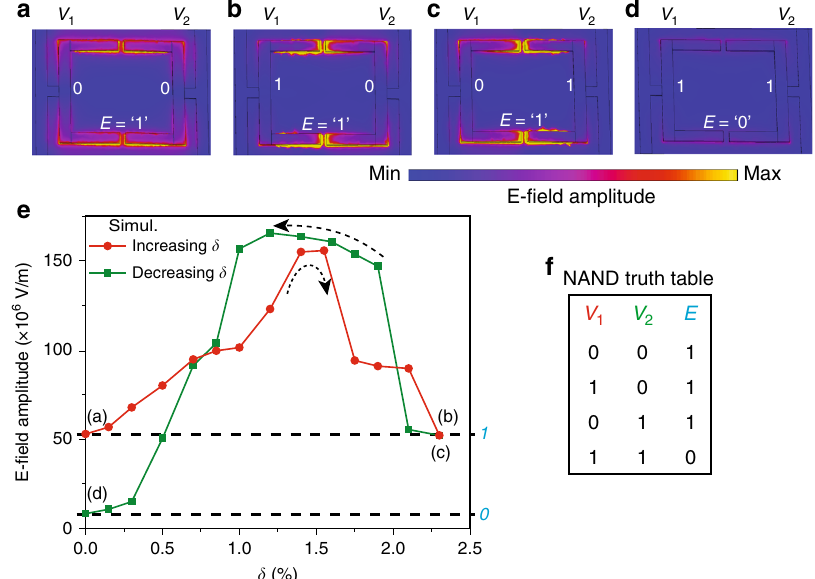
Fig. 5 NAND logic gate and multiple-input – output states in the near- fi eld con fi ned energy of MEMS Fano-metasurface. a – d The numerically calculated electric fi eld distributions at 0.55 THz, where a – c represent the true states of the electric fi eld con fi nement ( E = 1 ), whereas d shows the false state of E (i.e. E = 0 ), signifying the construction of NAND logic operation that is tabulated in ( f ). The input logic states 0 and 1 for V 1 and V 2 represent the ‘ up ’ and ‘ down ’ actuation states of SRR cantilevers, respectively. e Distinctive variations shown for the enhanced spatially con fi ned electric near- fi eld strengths in the device at Fano frequencies (0.55 THz) that possess MIO behaviour during sequential actuation of the SRR-1 (increasing δ ) and SRR-2 (decreasing δ ). The electric fi eld strength is measured at the tip position of the SRR cantilevers. f NAND logic truth table generated from the electro-optical operation of proposed MEMS